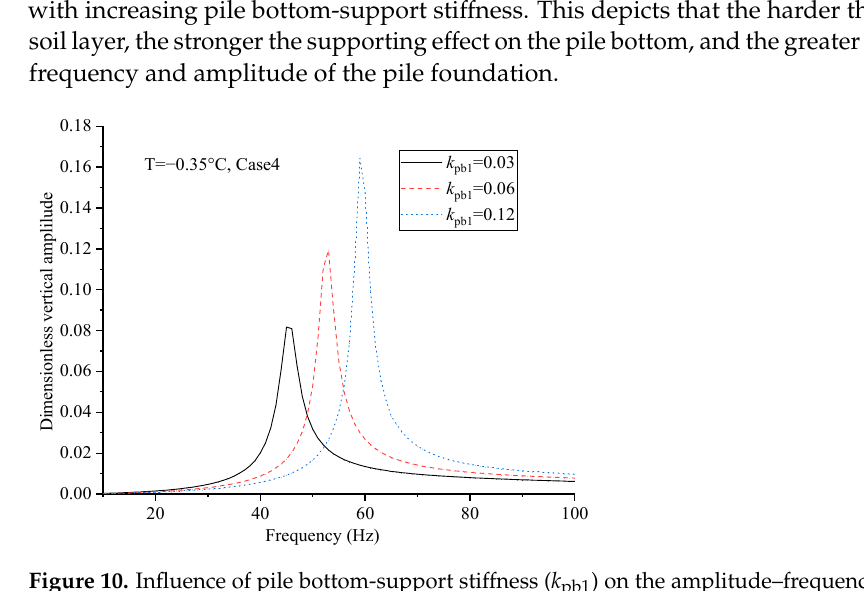
Figure 9. Effects of k s and k i on the amplitude–frequency curves of the pile foundations.